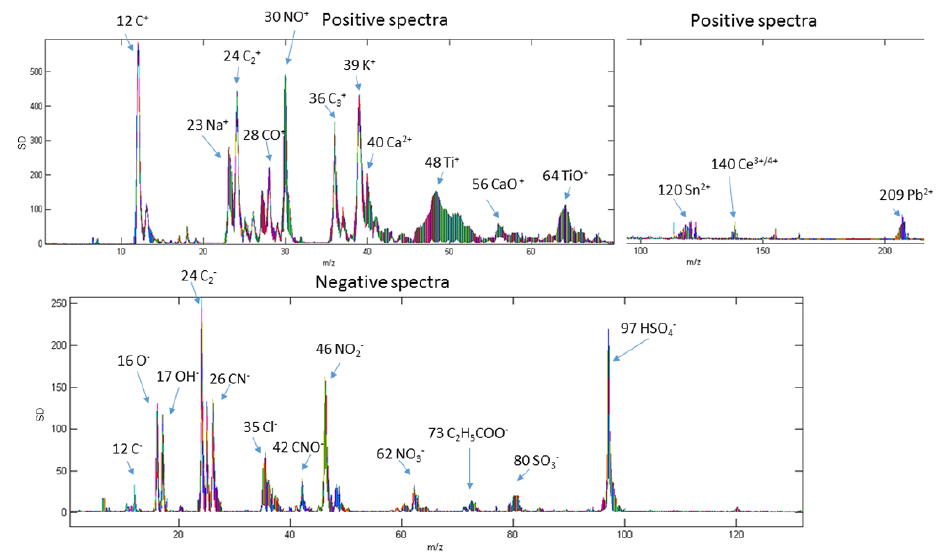
Figure 5. The standard deviation of all positive and negative ion mass spectra.